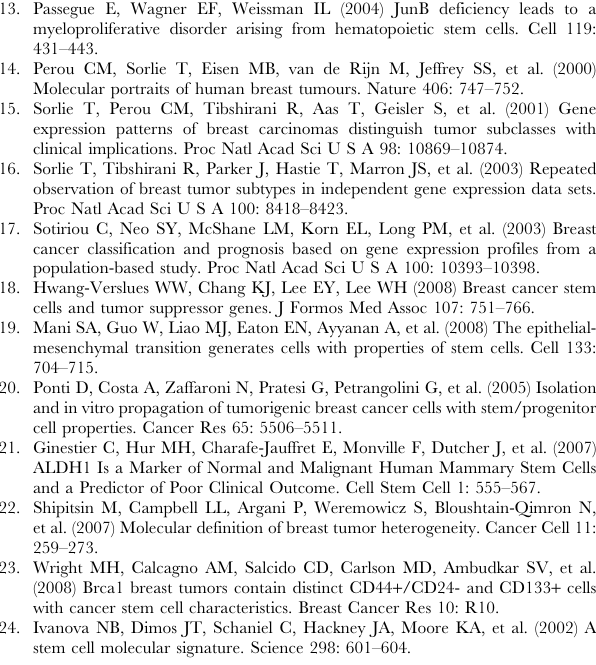
Figure S2 Soft agar colony forming efficiency of marker expressing or nonexpressing subpopulations from HCC1937 and ZR-75 cells. A. ALDH + and CXCR4 + identified two distinct subpopulations of ZR-75 cells which did not overlap with each other. B. Both ALDH + and CXCR4 + ZR-75 cells formed more colonies than the cells not expressing these markers. The ALDH + cells were more tumorigenic than the CXCR4 + cells. Shown is the relative fold increase of the colony forming efficiency normalized to the colony forming efficiency of the bulk population (means 6 SD). C. Selection of ALDH + cells failed to enrich the tumorigenic potential of HCC1937 cells. Shown is the percentage of colony formation (means 6 SD).